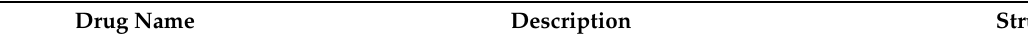
Table 6. Best performing molecules from the ZINC/FDA database.